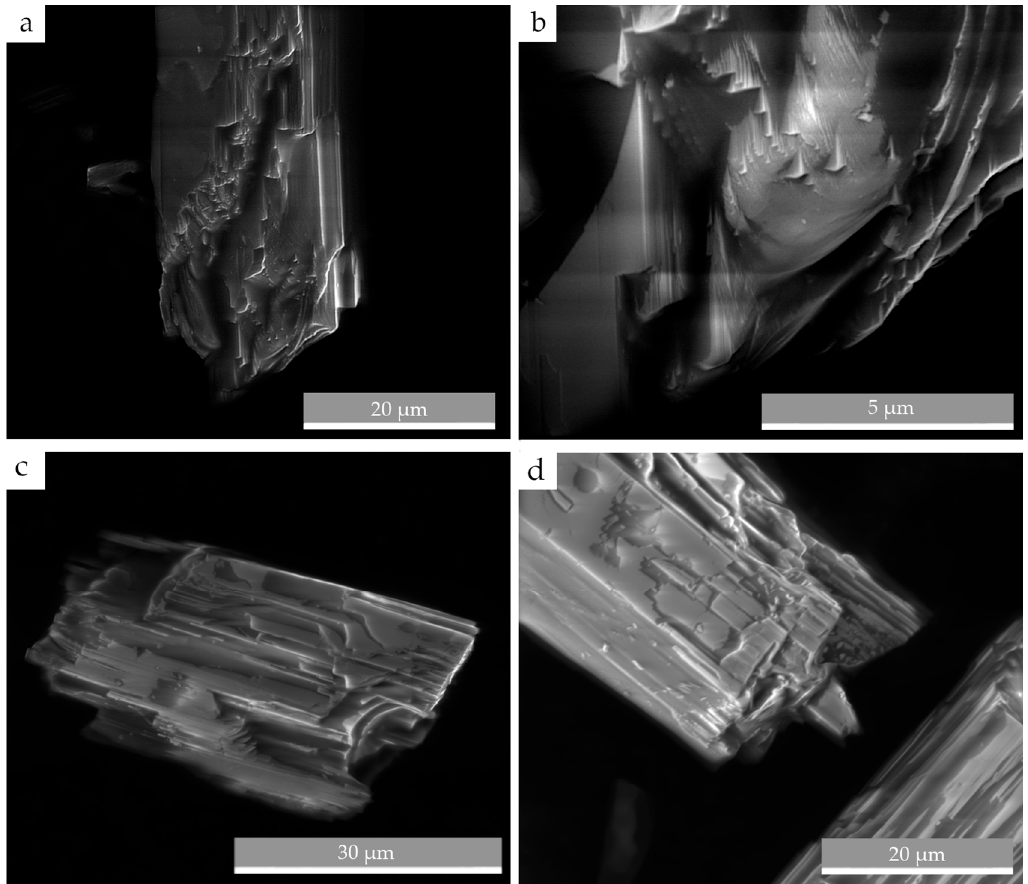
Figure 9. Selection of SE images showing three different particles collected after 168 h of interaction with Gamble’s solution. ( a ) particle with stepped, rounded, and consumed boundaries and apex, ( b ) detail of ( a ) showing rounded boundaries together with pyramid-shaped dissolution pits, ( c ) particle displaying extended rounded-boundary regions together with striated and stepped morphologies, and ( d ) particle surface with irregular